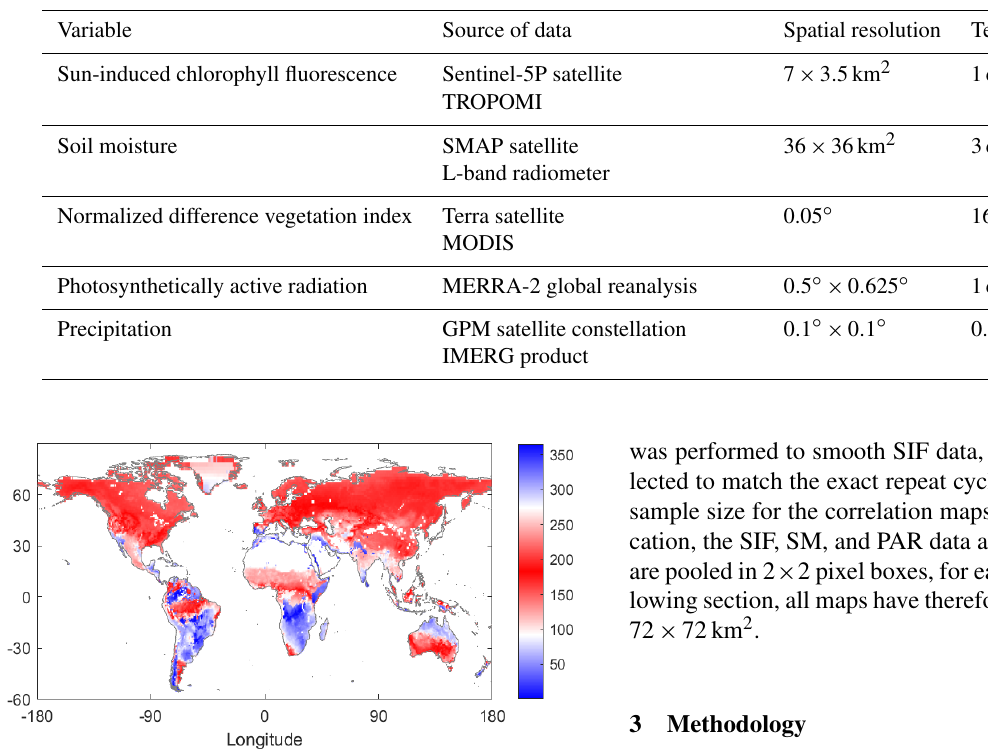
Figure 1. Growing-season determination based on MODIS nor- malized difference vegetation index (NDVI). Day of the year for the phenological peak based on MODIS NDVI climatology. White shading indicates NDVI was not available (bare soil or water bod-